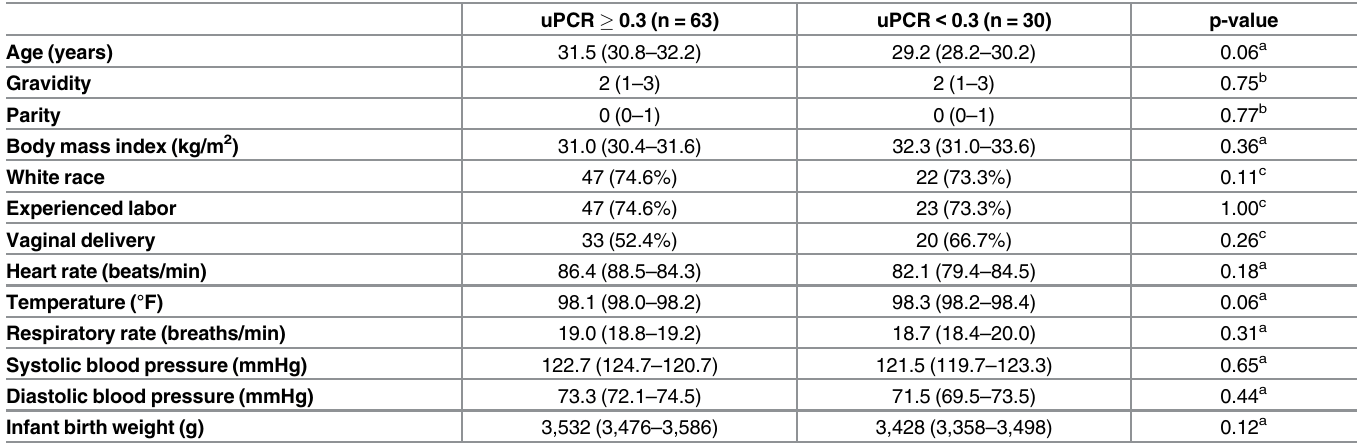
Table 2. Comparison of women with or without elevated urinary protein/creatinine ratio